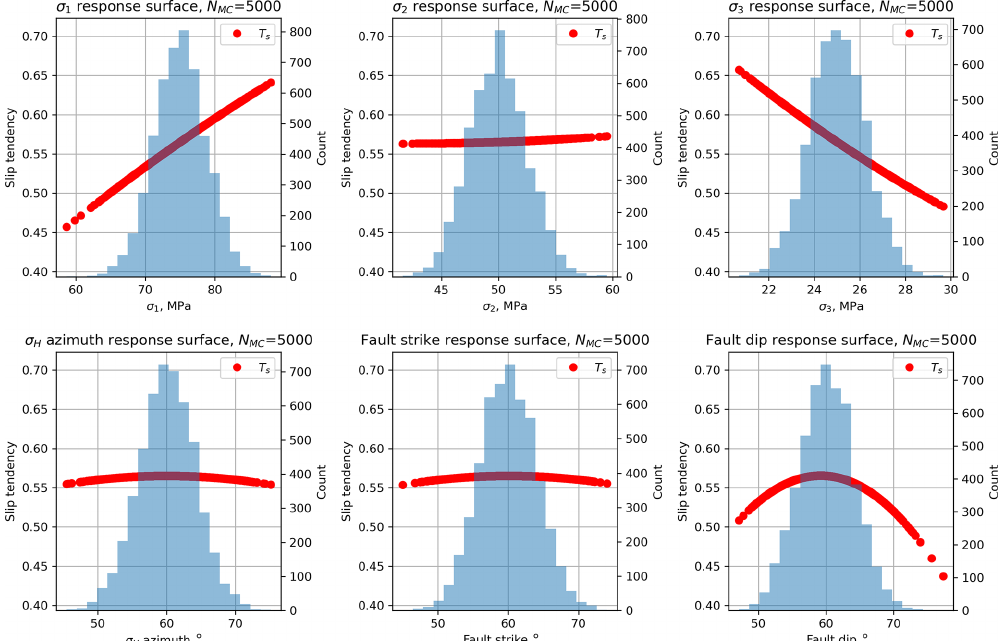
Figure 2. Histograms of input variables used to calculate slip tendency T s for the synthetic distributions shown in Table 2 (worked exam- ple one). Input value distributions are shown in blue. The calculated response surface is shown in red.